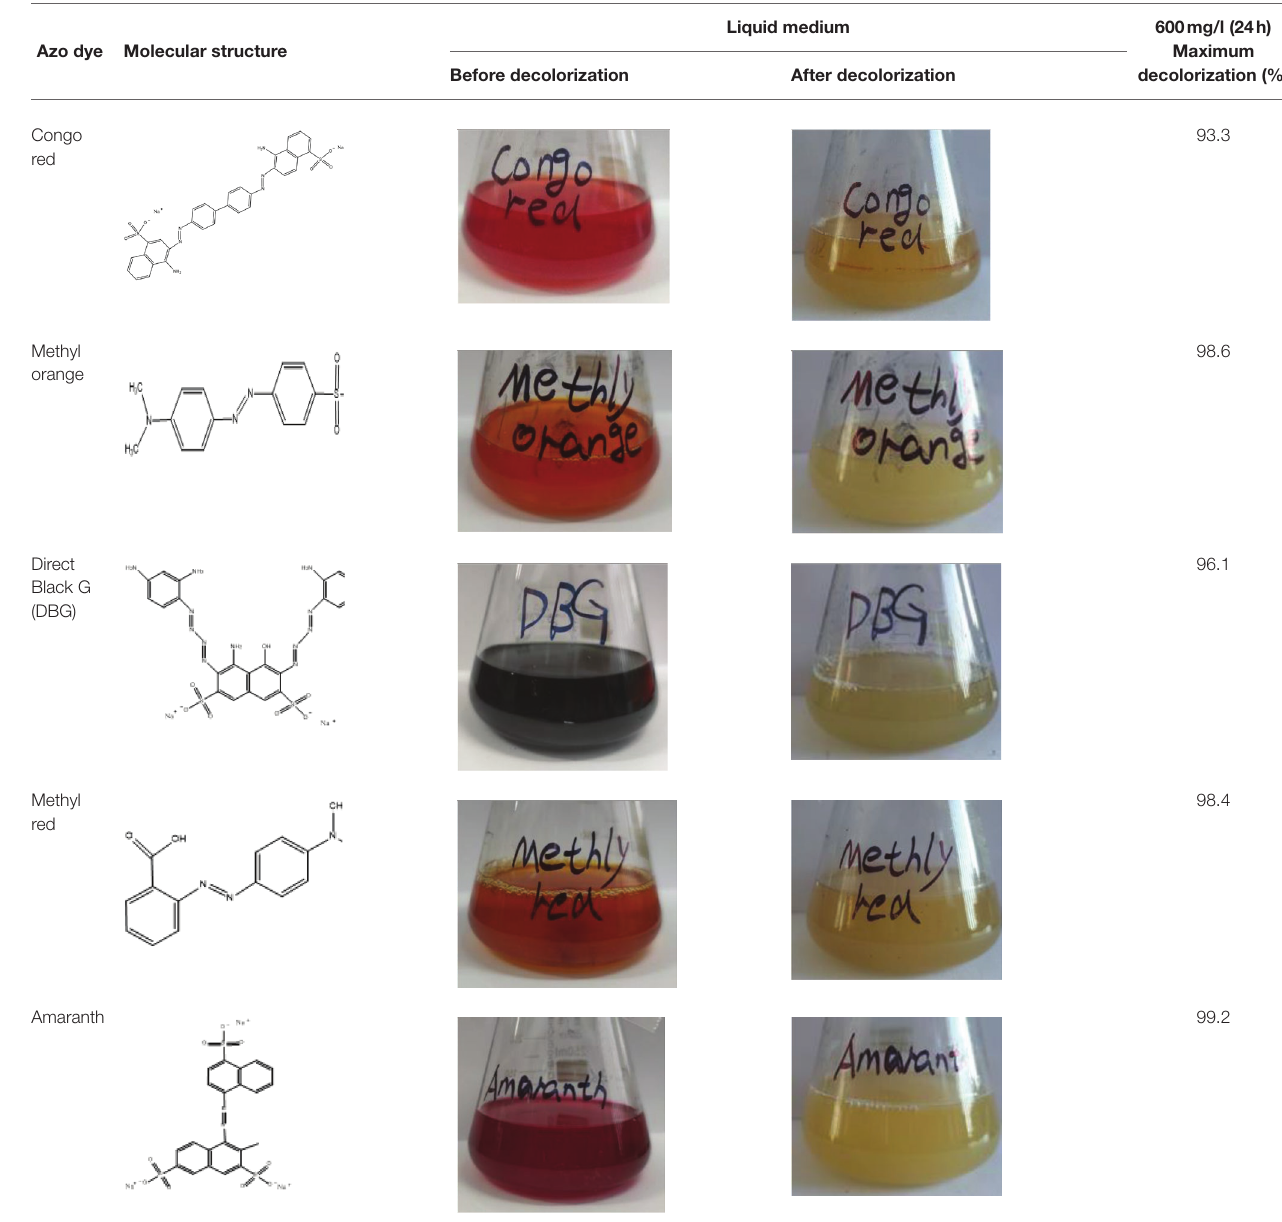
TABLE 2 | The ability of extreme halophilic/halotolerant bacteria to degrade azo dyes with different structures.